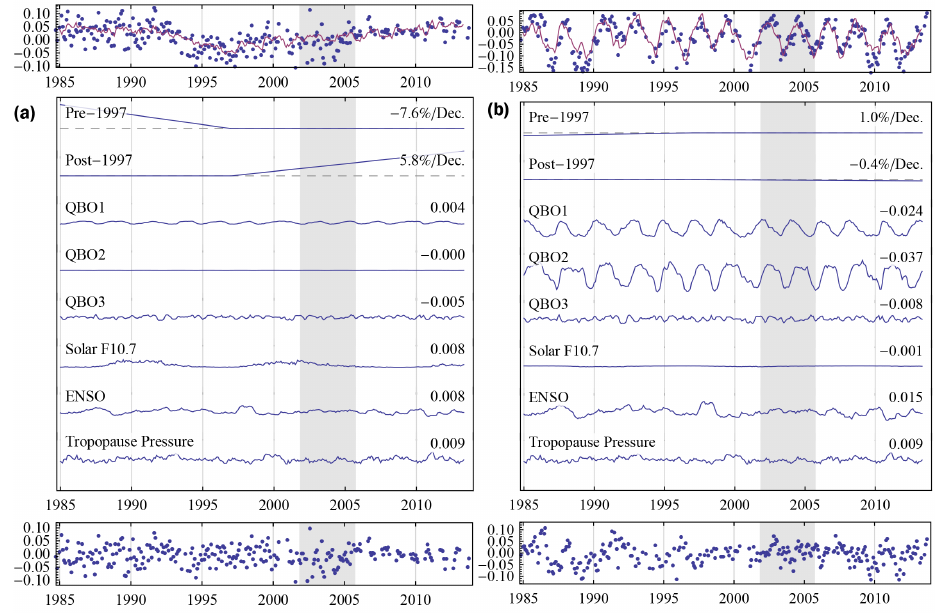
Figure 8. Same as Fig. 6. Left: 45 ◦ S–35 ◦ S at 42.5km altitude. The strongest change between pre- and post-1997 linear trends occurs in this region and similarly for the Northern Hemisphere at these latitudes. Right: 5 ◦ S–5 ◦ N at 32.5km altitude. In this region, the linear trends are reversed in direction compared to the remainder of the stratosphere, but are statistically insignificant.